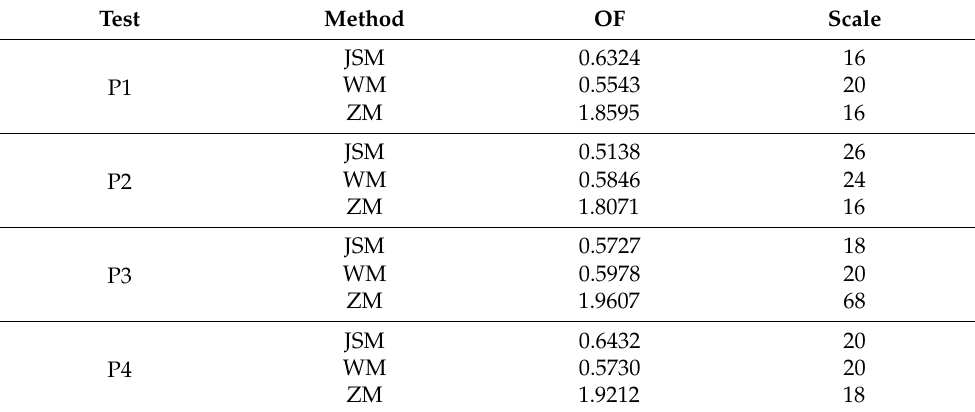
Table 3. Maximum value of the objective functions obtained using the three PO methods and the corresponding scales. Test Method OF Scale